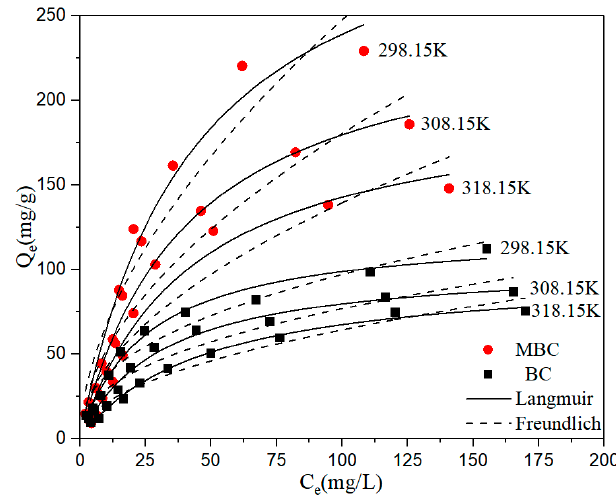
Figure 5. Adsorption isotherm fitting of BPA by BC and MBC. Table 5. Fitting parameters of isotherm fitting for BPA adsorption onto BC.